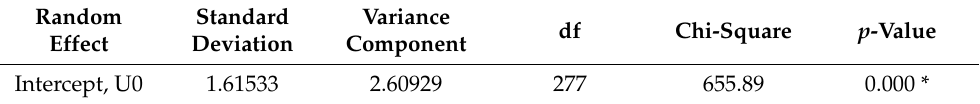
Table 4. Final estimation of variance components in the multilevel analysis (“null